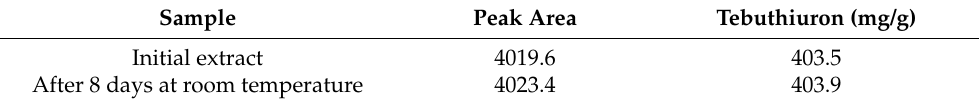
Table 2. Stability of the Regain methanolic extract after 8 days of storage at room